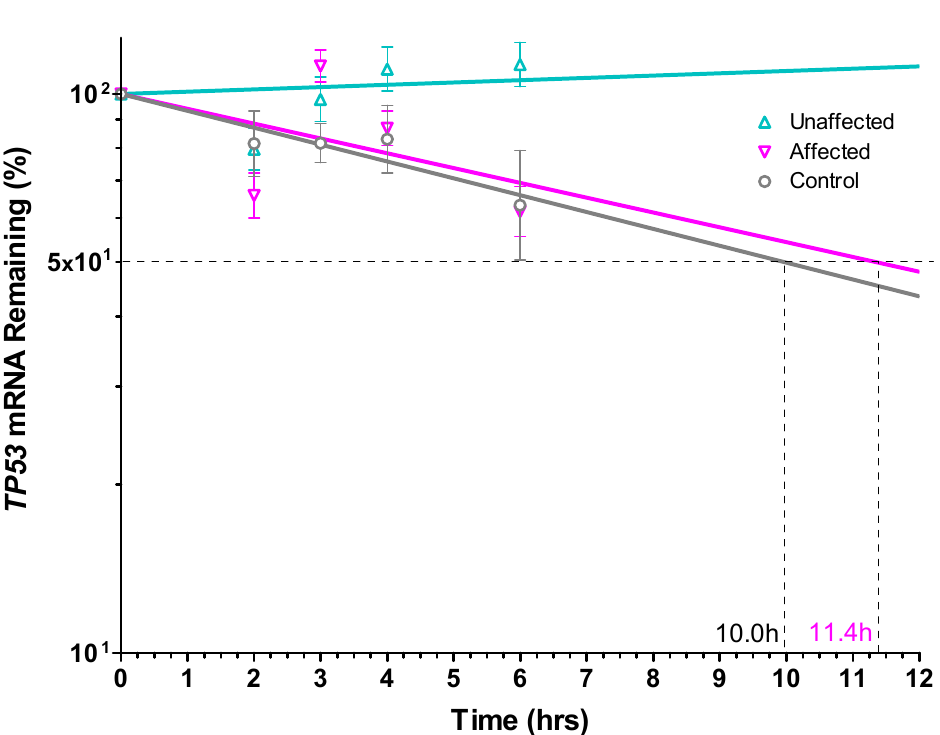
Figure 5. TP53 mRNA half-life by dFb from unaffected compared to the affected LFS or control subjects following UV exposure. Total dFb RNA was analyzed by RT-qPCR following transcriptional inhibition with actinomycin D for the time periods indicated after UV irradiation, as described. Expression of TP53 mRNA normalized relative to HPRT1 mRNA as a stable reference standard was calculated based on ΔΔ C q values at each sample time point ( n = 5). mRNA half-life (time after which 50% of initial TP53 mRNA remains) was calculated by curve fit regression analysis with Prism V.3 (GraphPad Software). ( ∆ ) Unaffected, ( ∇ ) Affected, and ( ○ ) Control.